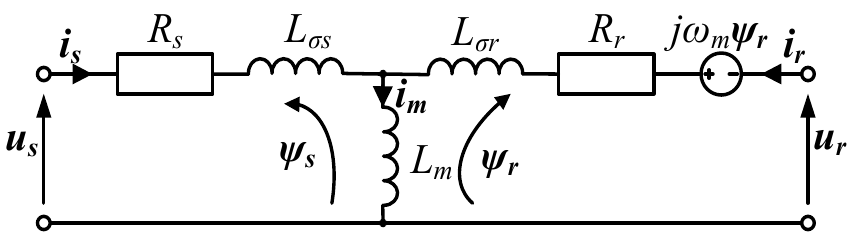
Figure 2. Electric circuit equivalent model of DFIG in the orthogonal αβ stationary frame.